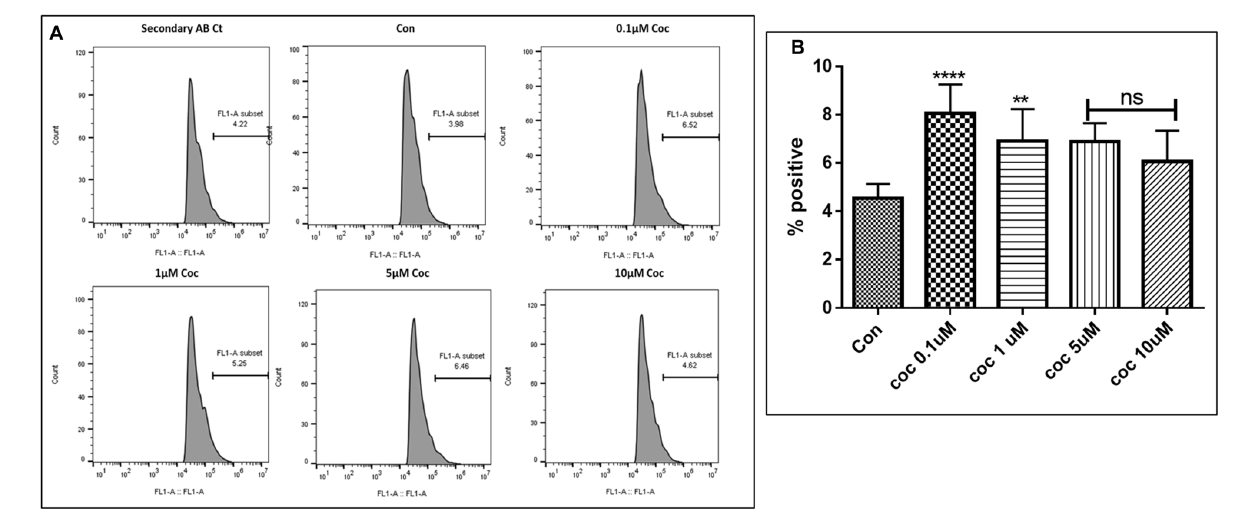
FIGURE 7 | Dose response. (A) Histograms showing coc (0.1–10 µ M) increases the A β 1–40 levels. The cells were treated with different concentrations of coc and after 48 h of treatment were analyzed by flow cytometry for determining the A β 1–40 levels. (B) Quantification representation of the percent positive cells ( ∗∗ p ≤ 0.01; ∗∗∗∗ p ≤ 0.0001; ns, not significant).